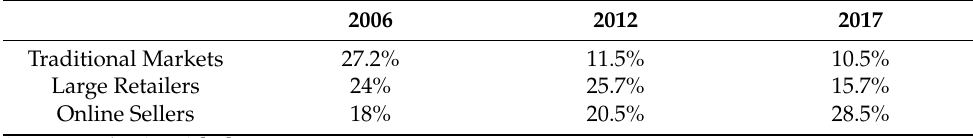
Table 2. Sales shares of large retailers, traditional markets, and online sellers.